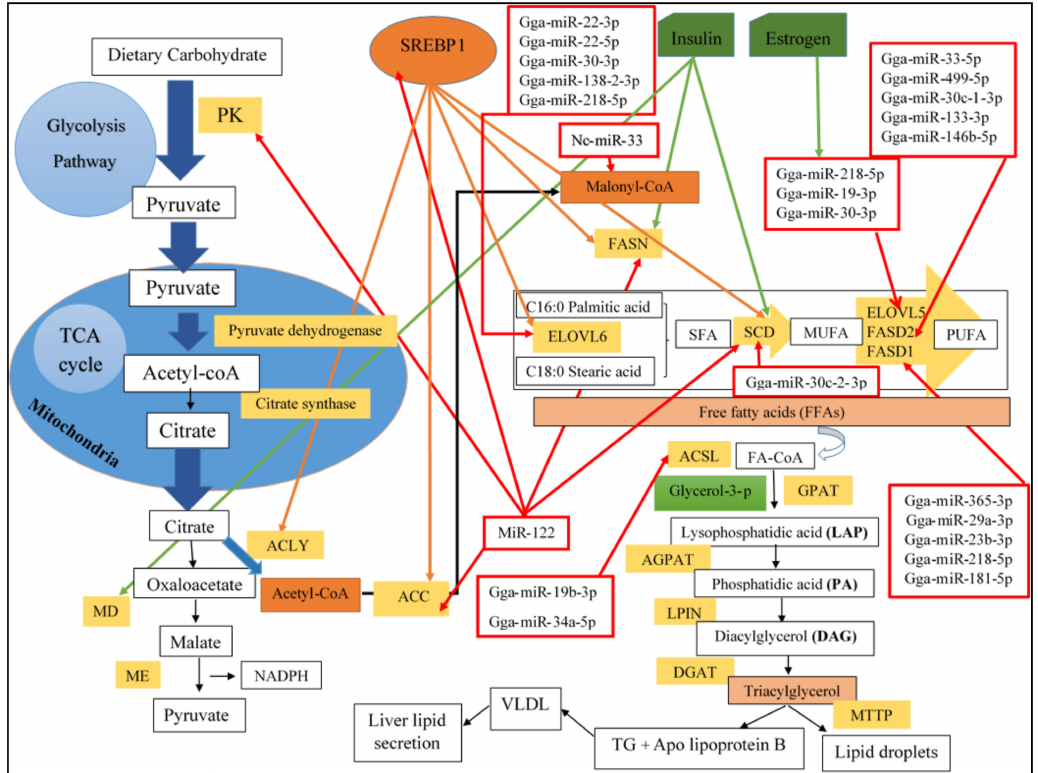
Figure 1. Schematic representation of de novo lipogenesis in chicken hepatocyte and its regulation at the transcriptional and post-transcriptional level. Red, orange, and green lines indicated the targets of various miRNAs, sterol response element-binding protein (SREBP1) as a transcription factor, and hormones in the chicken hepatocyte, respectively. PK, pyruvate kinase enzyme; TCA, tricarboxylic acid cycle; ACLY, ATP-citrate lyase; ACC, acetyl-CoA carboxylase; MD, malate dehydrogenase; NADPH, nicotinamide adenine dinucleotide phosphate; ME, malic enzyme; FASN, fatty acid synthase; ELOVL6, ELOVL fatty acid elongase 6; SCD, stearoyl-CoA desaturase; FADS, fatty acid desaturase; FA-CoA, fatty acid-acyl- CoA; ACSL, long-chain acyl-CoA synthetases; G3P, glycerol-3-phosphate; GPAT, glycerophosphate acyltransferase; AGPAT, acylglycerophosphate acyltransferase; LPIN, lipid phosphate phosphohydrolase; DGAT, diacylglycerol acyltransferase; MTTP, microsomal triglyceride transfer protein; VLDL, very-low-density lipoprotein; SFA, saturated fatty acid; USFA, unsaturated fatty acids; MUFA, monounsaturated fatty acids; PUFA, polyunsaturated fatty acids; FFA, free fatty